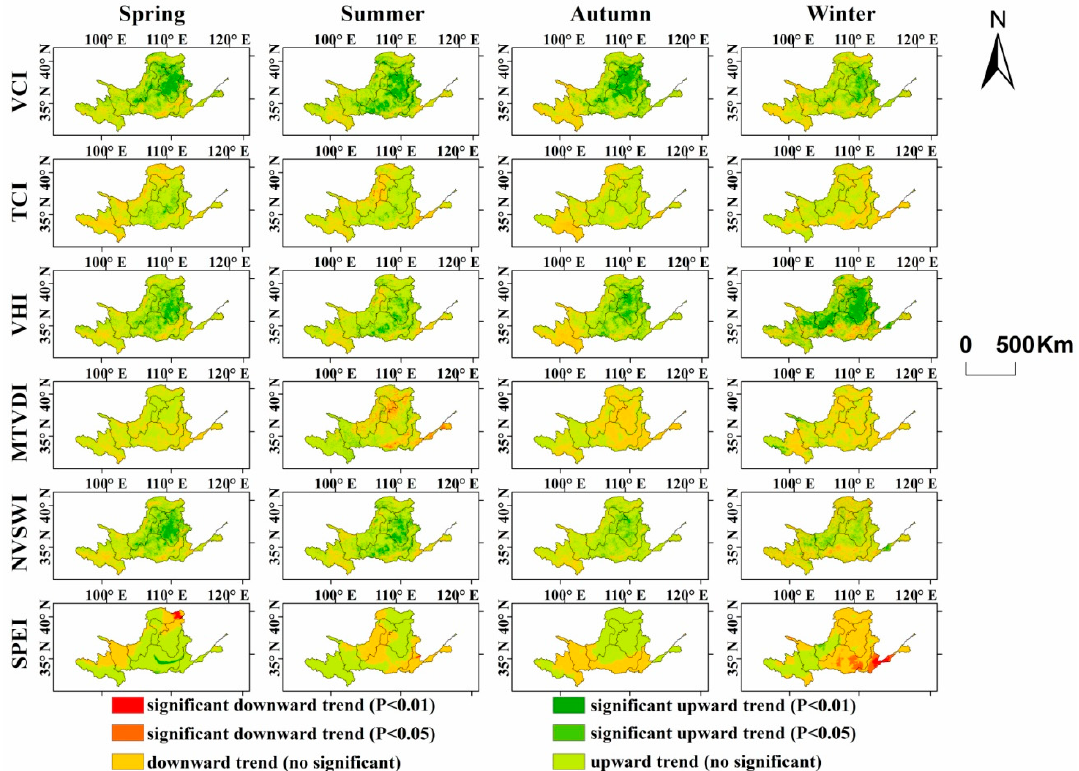
Figure 7. Seasonal trends of drought indices in the Yellow River basin (YRB) during 2000–2015.